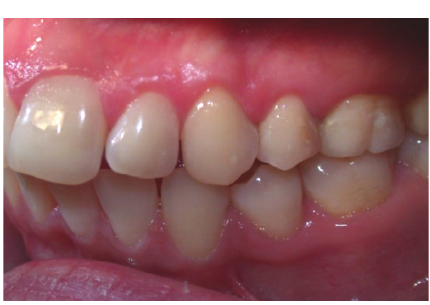
Figure 2: Lateral view (left).